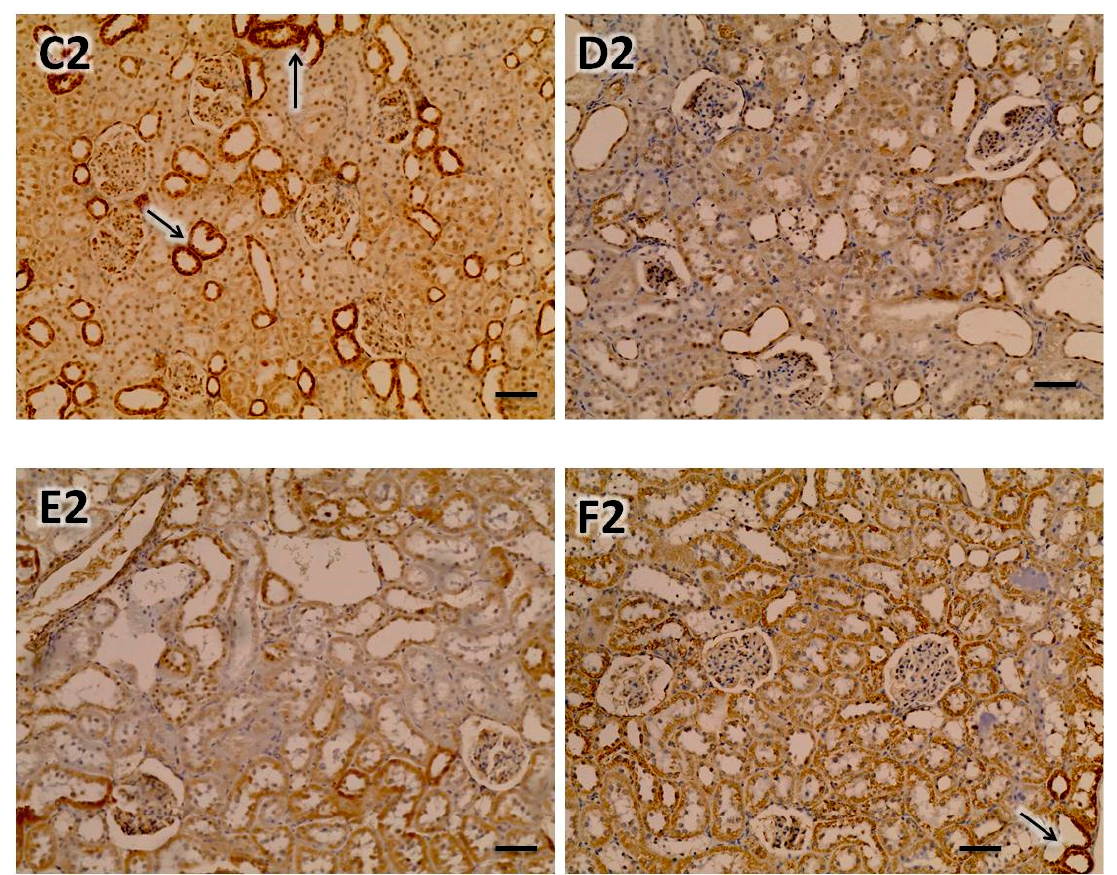
Figure 7. Represent immunohistochemical quantification and immunohistochemical staining in intensities of apoptotic markers. ( a ) Represents immunohistochemical quantification of caspase 9 in the kidney tissue; ( b ) immunohistochemical quantification of caspase 3 in the kidney tissue; ( c ) immunohistochemical quantification of BCL-2 in the kidney tissue. Immunohistochemical photo micrographs indicating staining intensities of different markers are represented as follows: caspase 9 plates ( A – F ), caspase 3 ( A1 – F1 ) and BCL-2 ( A2 – F2 ). Arrows represent areas of hyper intensity in varying degrees of the brown stain. Data represented as means ± SEM. a p < 0.05 vs. normal control. b p < 0.05 vs. diabetic control. c p < 0.05 vs. normal rats treated with vindoline. d p < 0.05 vs. normal rats treated with glibenclamide. (NC; A; A1; A2) Normal control; (NV; B; B1; B2) normal control treated with vindoline; (NG; C; C1; C2) normal control treated with glibenclamide; (DC; D; D1; D2) diabetic control; (DV; E; E1; E2) diabetic treated with vindoline; and (DG; F; F1; F2) diabetic treated with glibenclamide. (Scale bar: 50 µm)